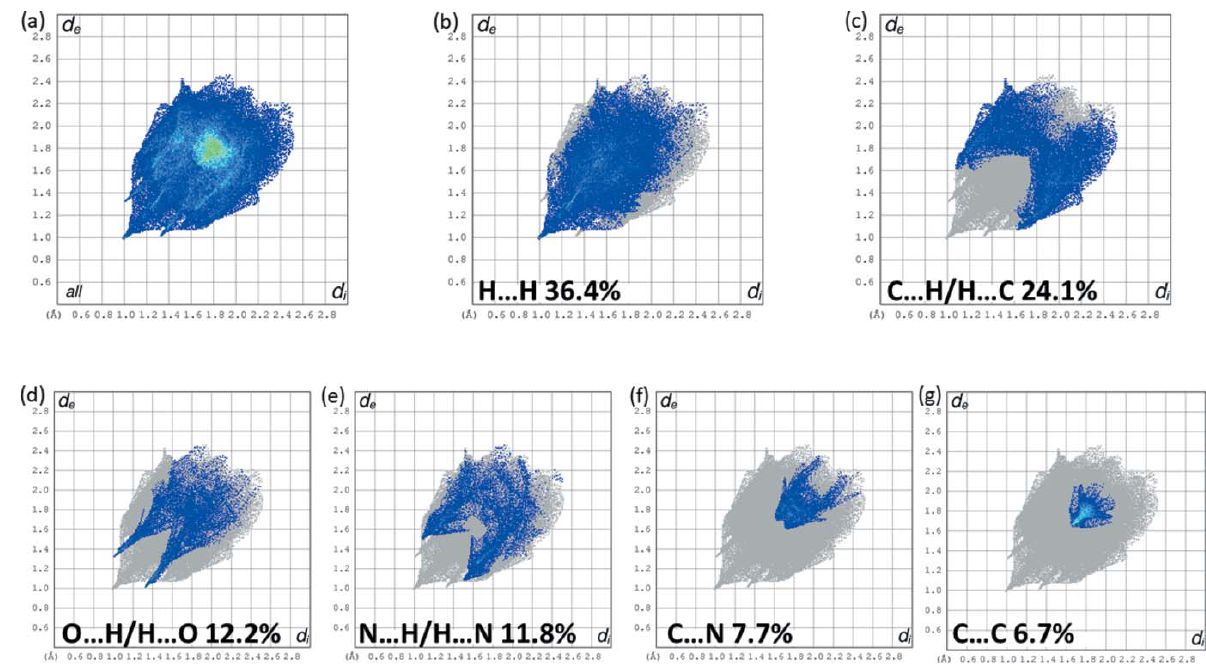
Figure 9 ( a ) The full two-dimensional fingerprint plot for H 2 L1 and the fingerprint plots delineated into ( b ) H (cid:3)(cid:3)(cid:3) H, ( c ) C (cid:3)(cid:3)(cid:3) H/H (cid:3)(cid:3)(cid:3) C, ( d ) O (cid:3)(cid:3)(cid:3) H/H (cid:3)(cid:3)(cid:3) O, ( e ) N (cid:3)(cid:3)(cid:3) H/H (cid:3)(cid:3)(cid:3) N, ( f ) C (cid:3)(cid:3)(cid:3) N, ( g ) C (cid:3)(cid:3)(cid:3) C